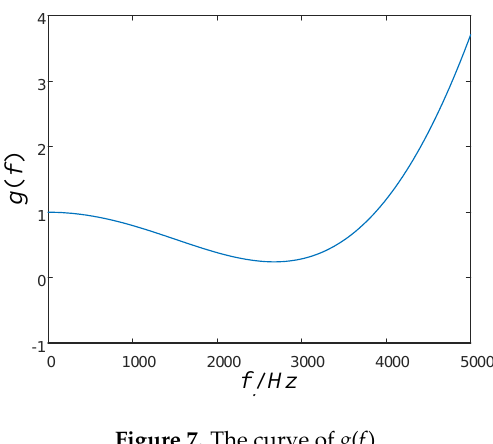
Figure 7. The curve of g ( f ).